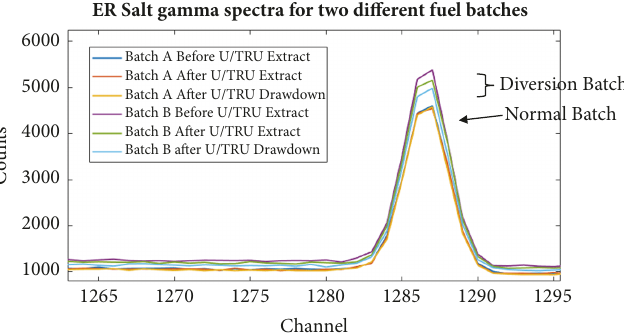
Figure 5: ER salt gamma peak during one normal batch and one substitution diversion.